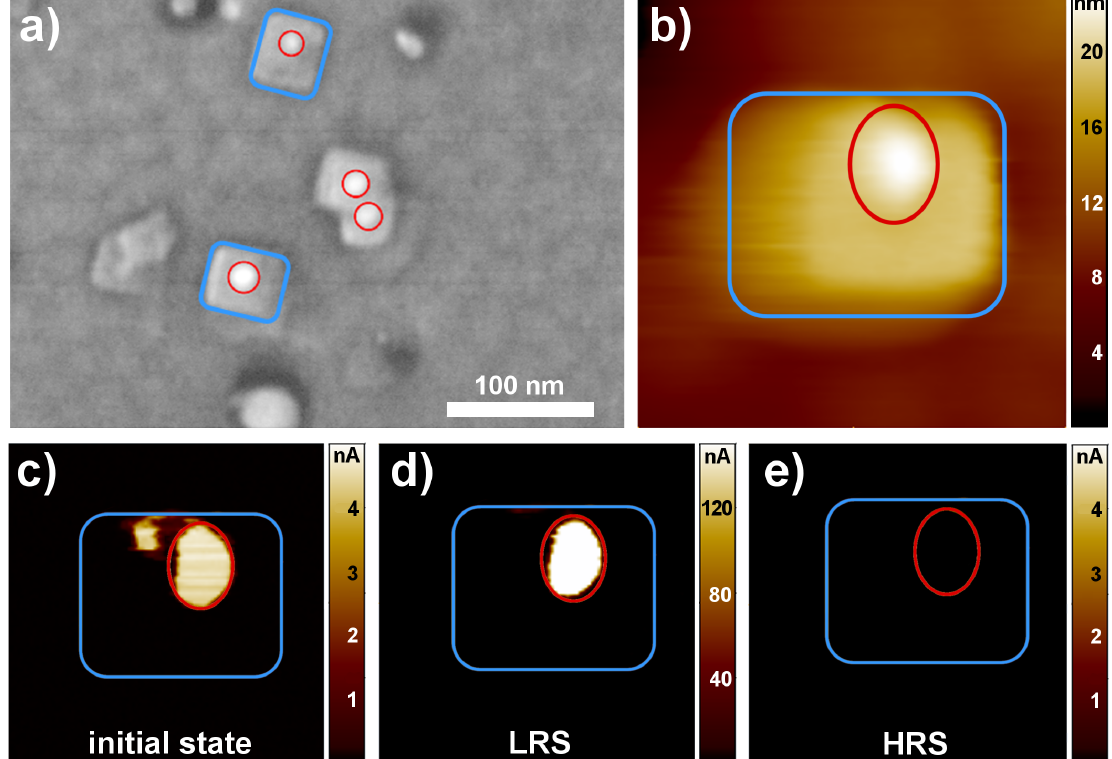
Figure 3. TypeI resistive switching directly at the AuNP. ( a ) SEM image with characteristic rectangular structures (blue) and AuNPs (red) as the bright spot. ( b ) Topography image of a 30-nm stoichiometric SrTiO 3 thin film, containing both a rectangular structure and an AuNP. ( c – e ) Current images measured with a read out voltage of +0.5V in the same area as (b). For the initial (c), the low resistive state (LRS) after (a) a scan with +2V (d) and the high resistive state (HRS) after (a) scan with − 2V (e). All local conductive atomic force microscopy (LC-AFM) images were taken with a scan size of 100nm ×